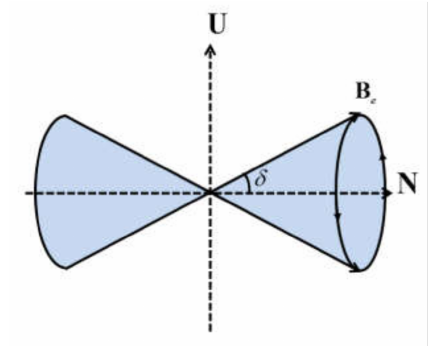
Figure 3. External precessional magnetic field to control the CMR.